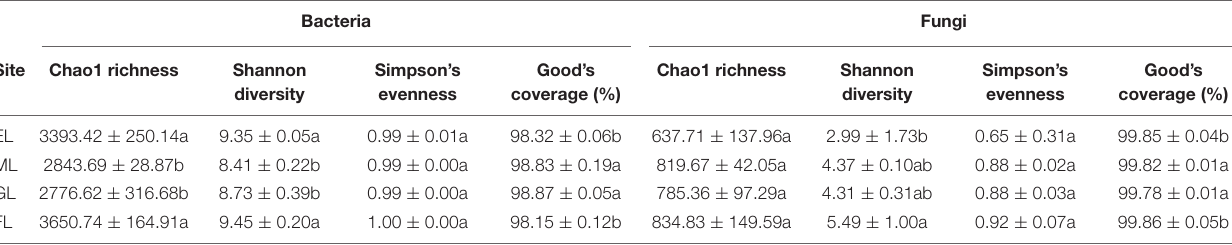
TABLE 3 | Soil alpha diversity in different land use types.